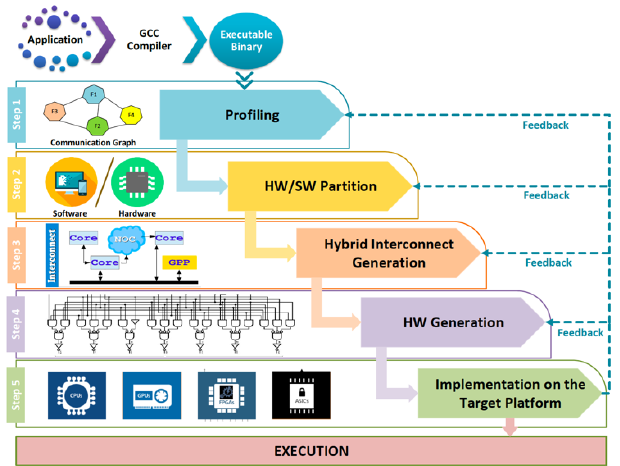
Figure 1. The proposed framework proposed in